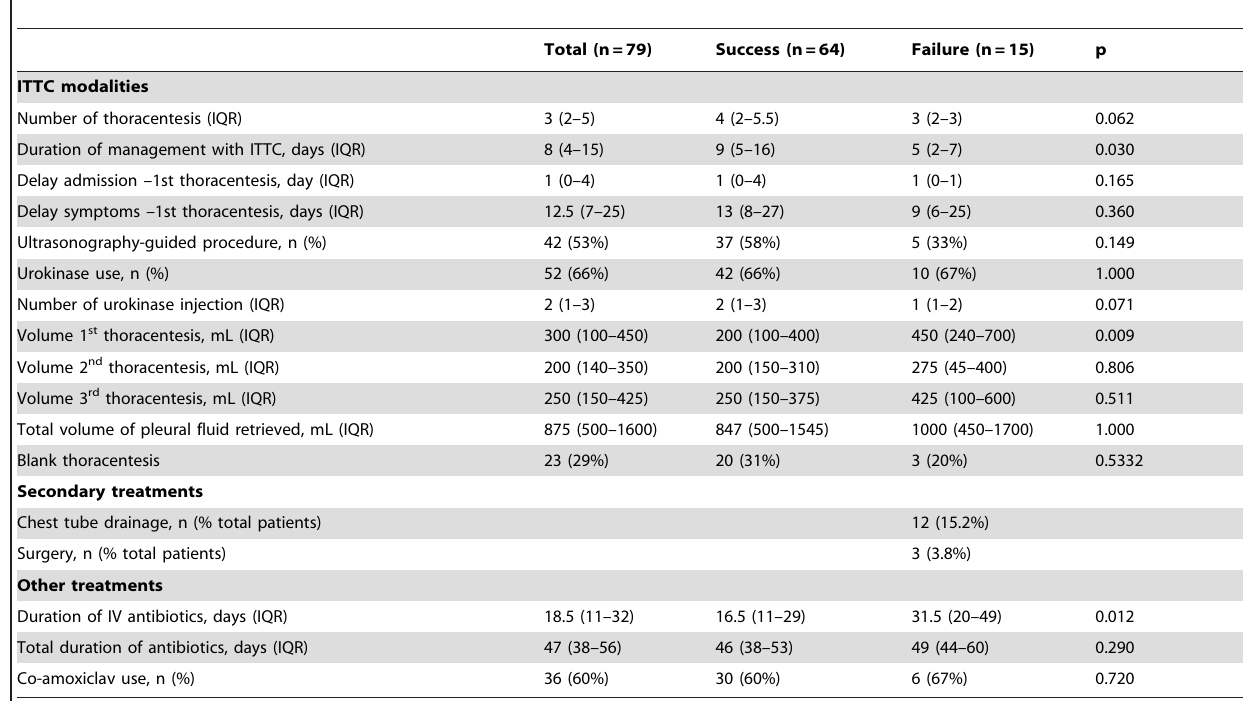
Table 3. Iterative therapeutic thoracentesis (ITTC) modalities and secondary